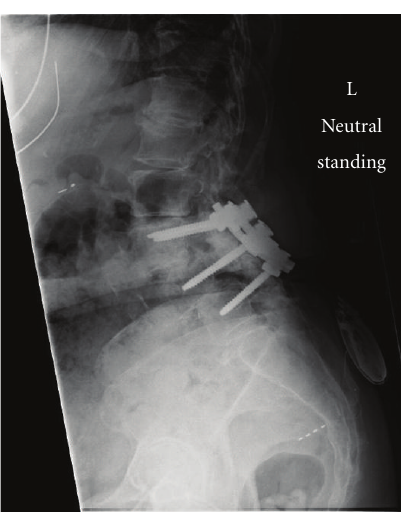
Figure 3: Lateral radiograph of the lumbosacral spine showing prior L3–L5 posterior fusion and instrumentation. However, there is adjacent segment degeneration cephalad to the instrumentation at L2-L3.